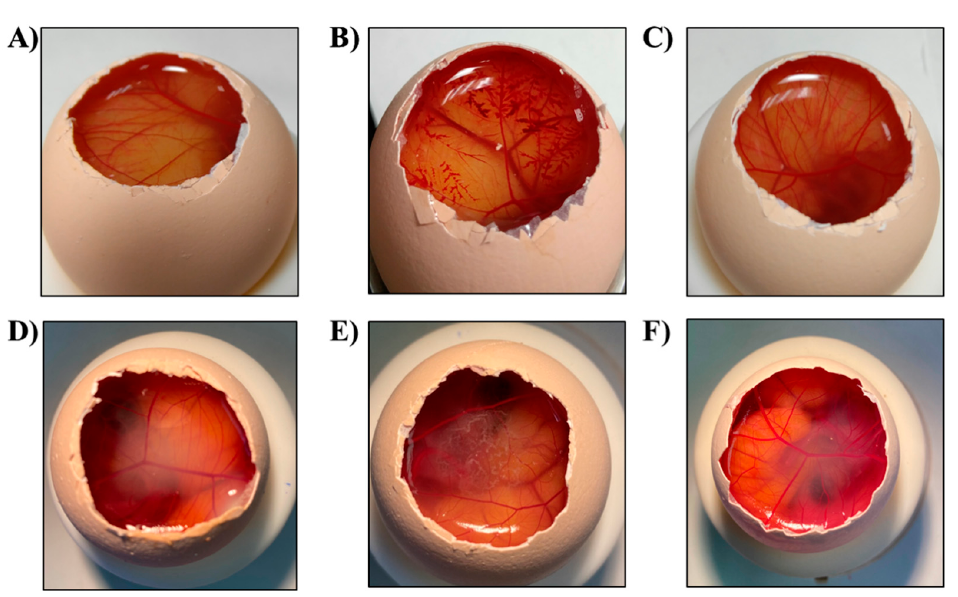
Figure 6. HET-CAM assessment images after 5 min of the product application. ( A ) NaCL, ( B ) NaOH, ( C ) SDS 1%, ( D ) Lico-A PLGA NPs, ( E ) Lico-A PLGA-PEG-Tet-1 NPs, ( F ) Lico-A PLGA-PEG-B6